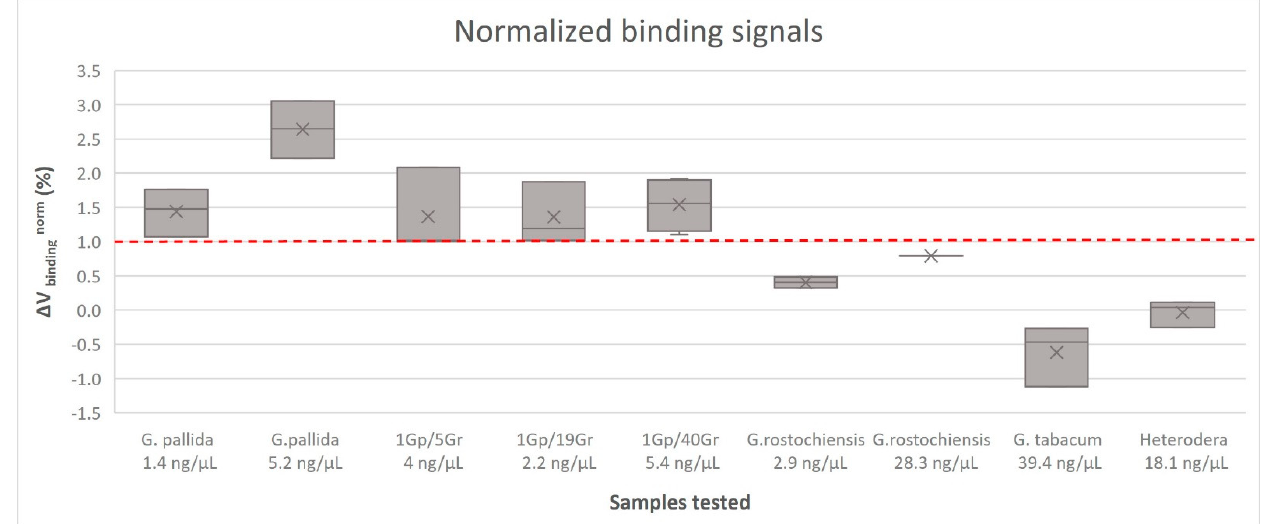
Figure 4. Normalized binding signals obtained for each sample group, obtained from asymmetric PCR against the specific probe for Globodera pallida detection. The error bars are standard deviations coming from at least 12 sensors acquired from three measures for each sample. The dashed line represents the threshold, a minimum value above which a detection signal is considered positive. DNA of pure samples ( Globodera pallida , G. rostochiensis , G. tabacum and Heterodera sp.) was extracted from cysts and DNA extracted from pooled samples was extracted from mixed juveniles.